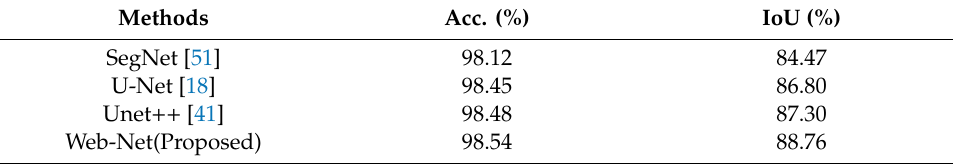
Table 7. Numerical Results of the State-of-the-art models on WHU